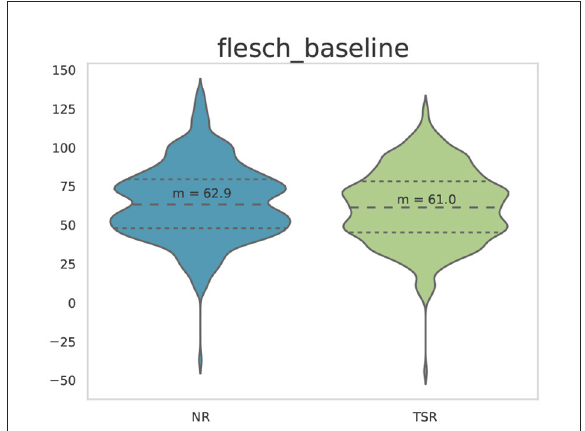
FIGURE5 Flesch reading ease (FRE) scores for the NR and TSR sentences used in the ZuCo 2.0.